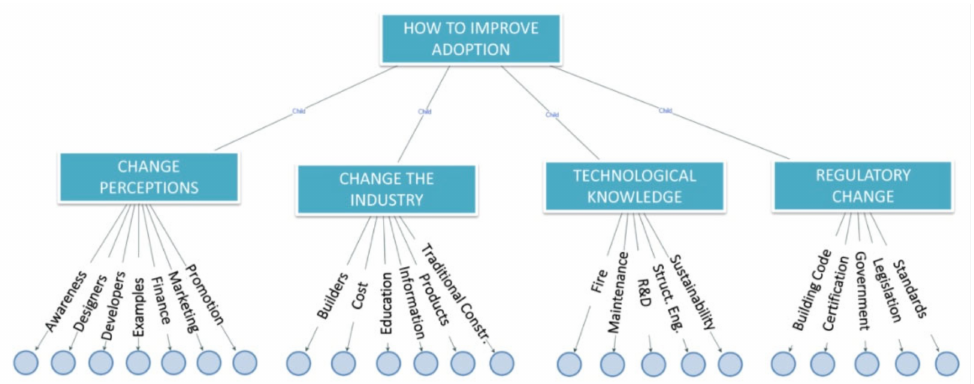
Figure 13. Tree map of themes identified to enhance